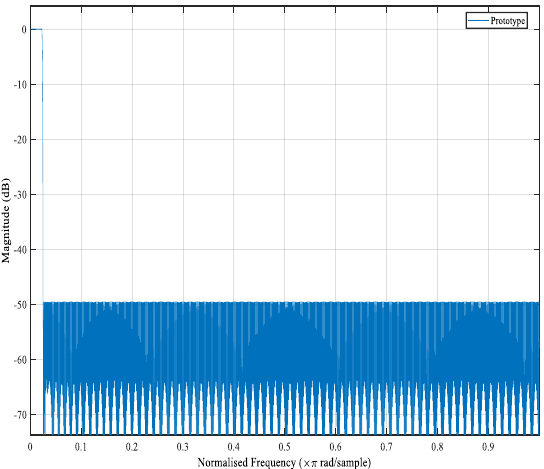
Figure 6. Magnitude response for the modal filter using the HFarrow algorithm.